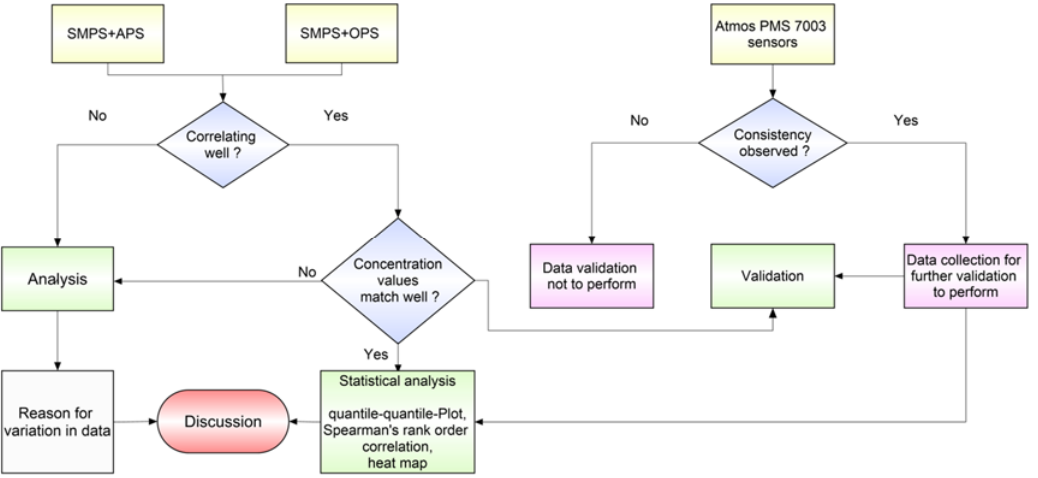
Figure 2. Schematic diagram showing the methodology used in this study.